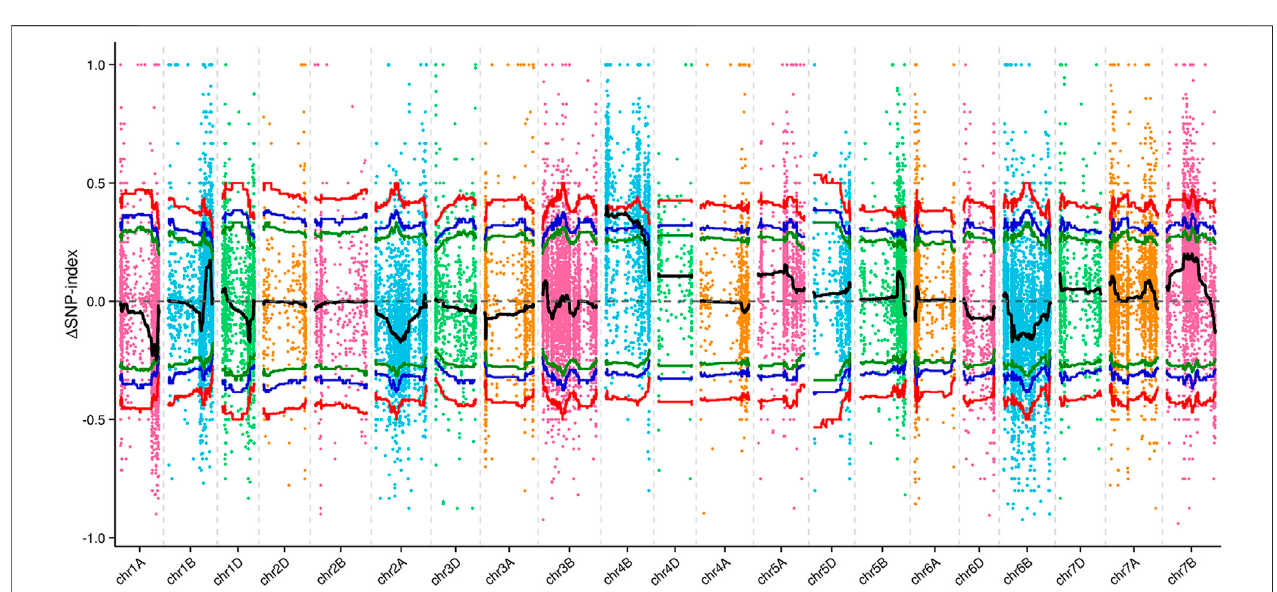
Frontiers in Genetics |